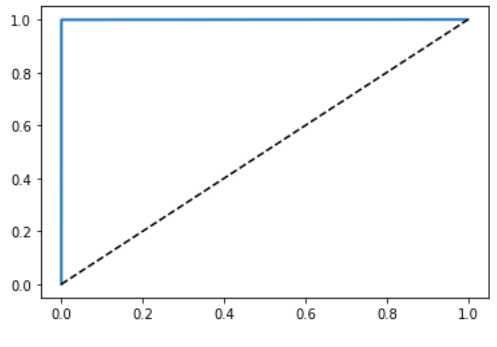
Figure 10. ROC curves of GD, SVM, LR, RF, HVG, SVG, HVR, SVR.